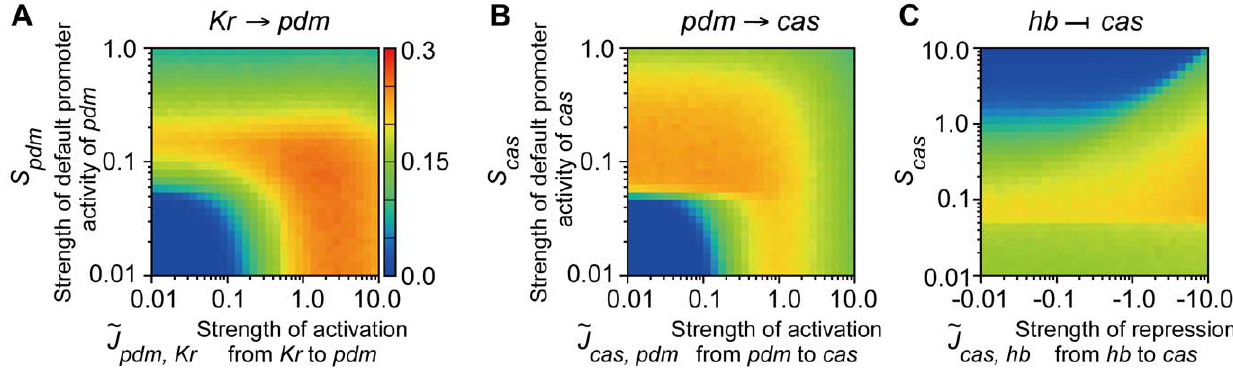
Figure 8. Parameter dependencies of robustness for the Drosophila network. The fractions of successes for random assignment of parameter values are plotted under thedifferent strengths of regulations ( ~ JJ pdm , Kr , ~ JJ cas , pdm , and ~ JJ cas , hb ) and default promoter activities ( S pdm and S cas ). Dependencies of robustness to ( A ) ~ JJ pdm , Kr (strength of activation from Kr to pdm ) and S pdm , ( B ) ~ JJ cas , pdm (strength of activation from pdm to cas ) and S cas , and ( C ) ~ JJ cas , hb (strength of the repression from hb to cas ) and S cas . The other parameters are set as listed in Table 4. The temporal dynamics were tested for 50,000 trials.